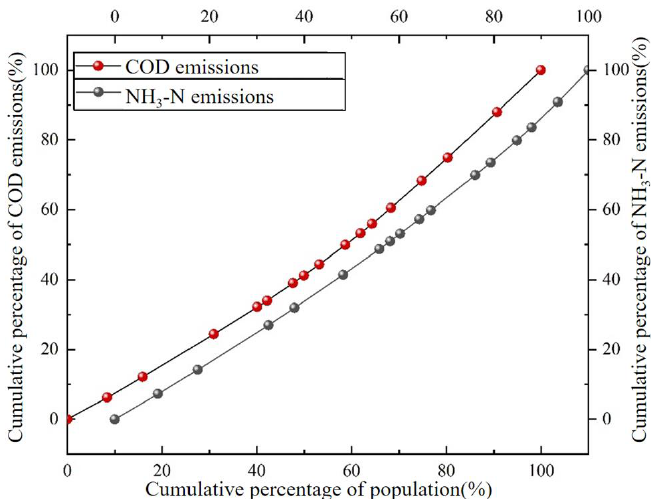
Figure 3. Lorenz curves of COD and NH 3 -N based on population.